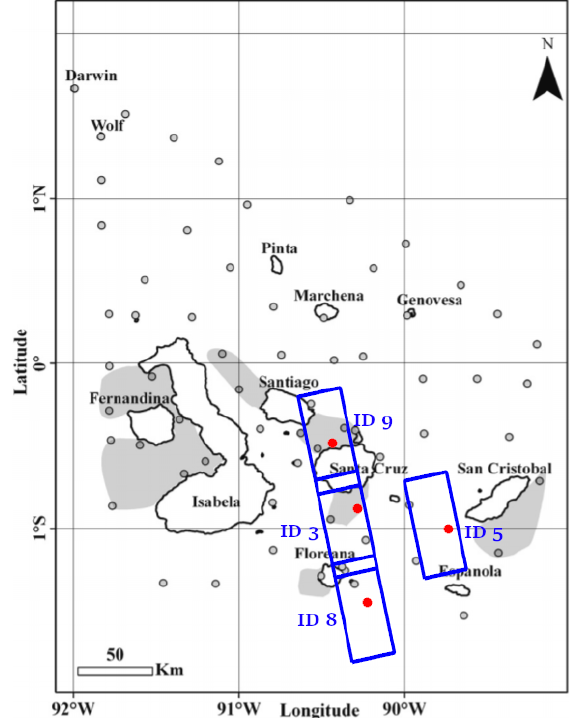
Figure 11. Frames of the SAR images associated to the IW single-negative sign signature (blue rectangles) overlaid to the productive habitats of the GMR indicated as gray shaded regions. The red dots show the region where the IW profiles were extracted. Adapted from Figure 10 in